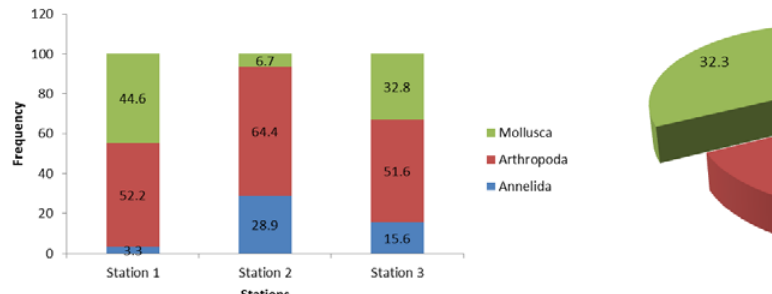
Fig. 2. Percentage contribution of macroinvertebrate groups in the study stations of River Idemili